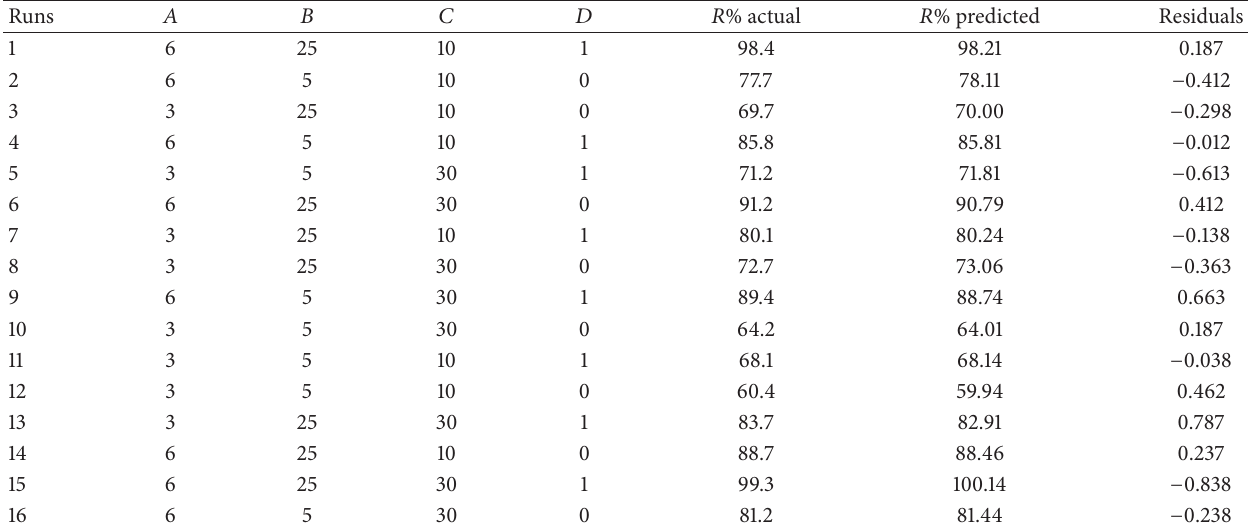
Table 3: 2 4 full factorial experimental design with actual levels.